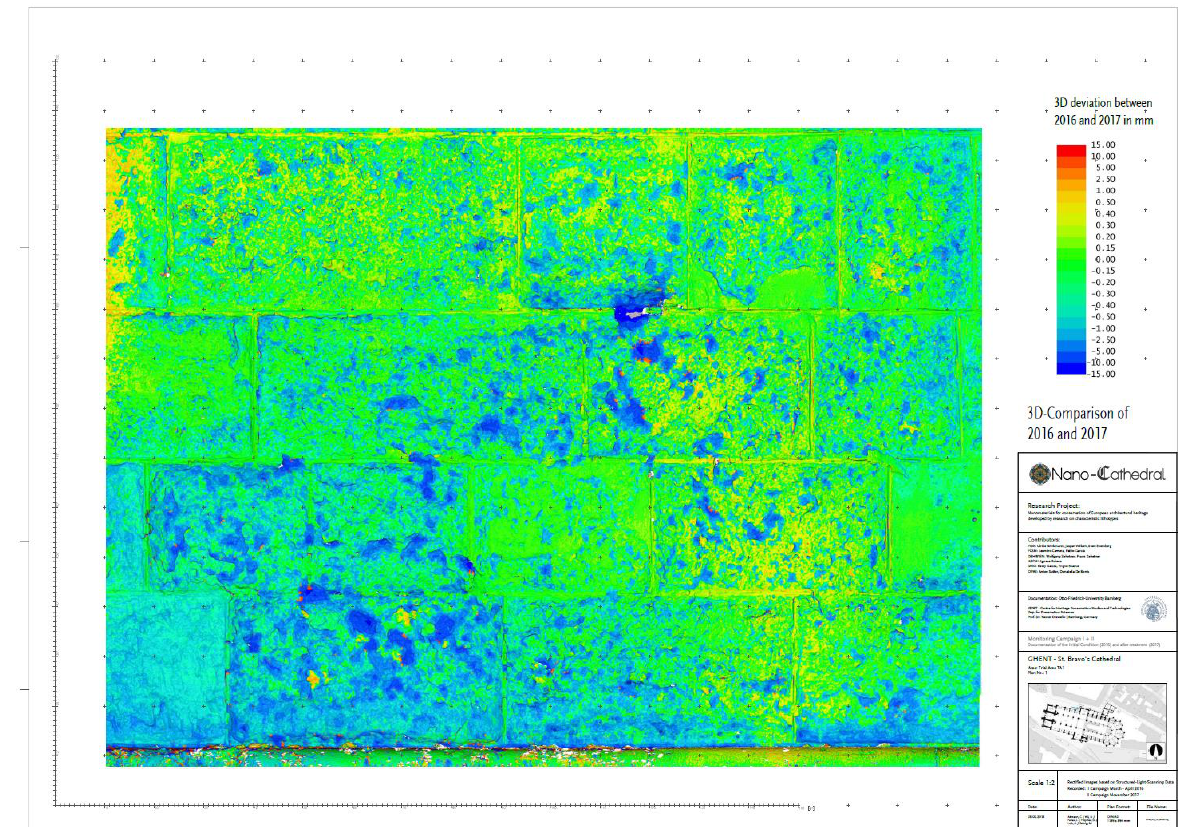
Figure 3. Trial area 1 at Sint Baafs Cathedral: 3D comparison of campaign 2016 and 2017. Stable areas are shown in green, red to yellow shows a growth and turquoise to blue a loss of the